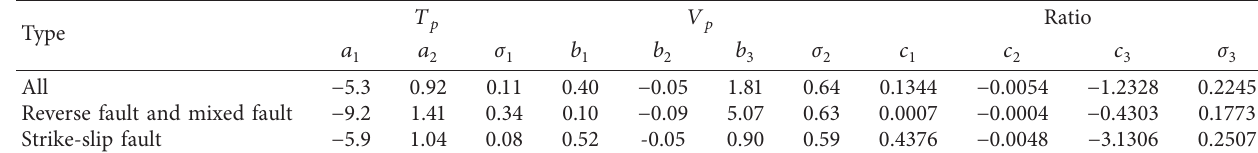
V p , p , and ratio for different faults.